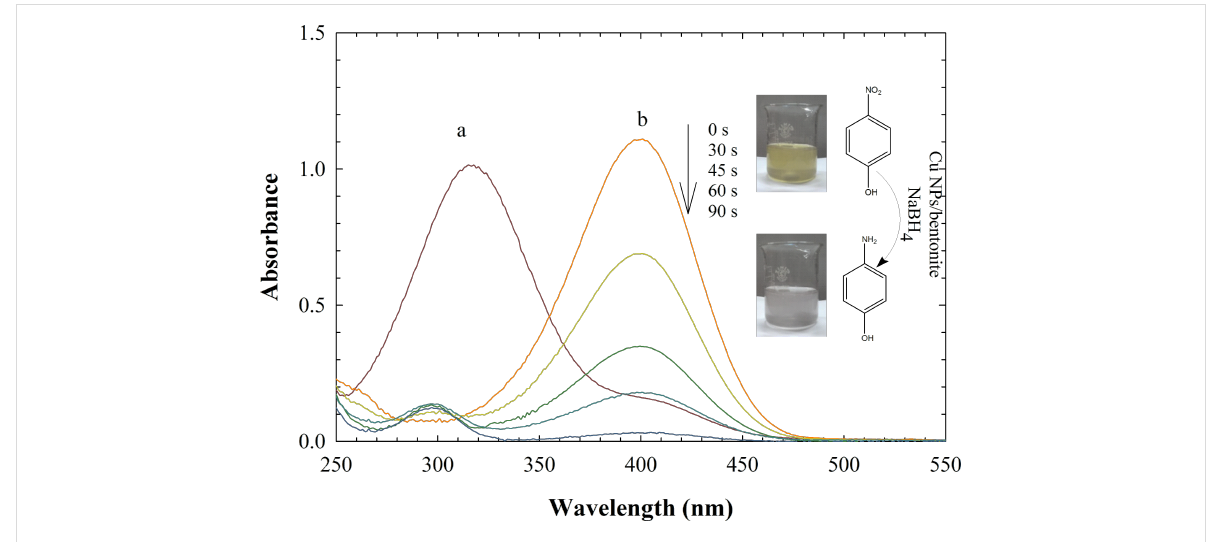
Figure 9: UV–vis absorption spectra of 4-NP (a) and 4-NP + NaBH 4 (b) at several intervals. Conditions: [4-NP] = 2.5 × 10 − 3 M; [NaBH 4 ] = 0.25 M; catalyst = 15 mg.